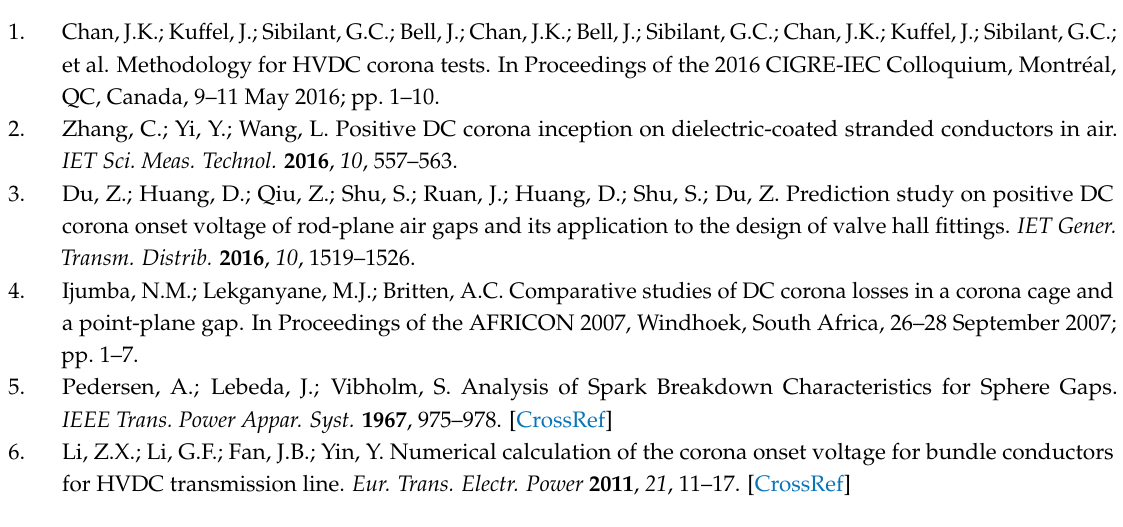
Table 5. Visual corona extinction for the substation connector.